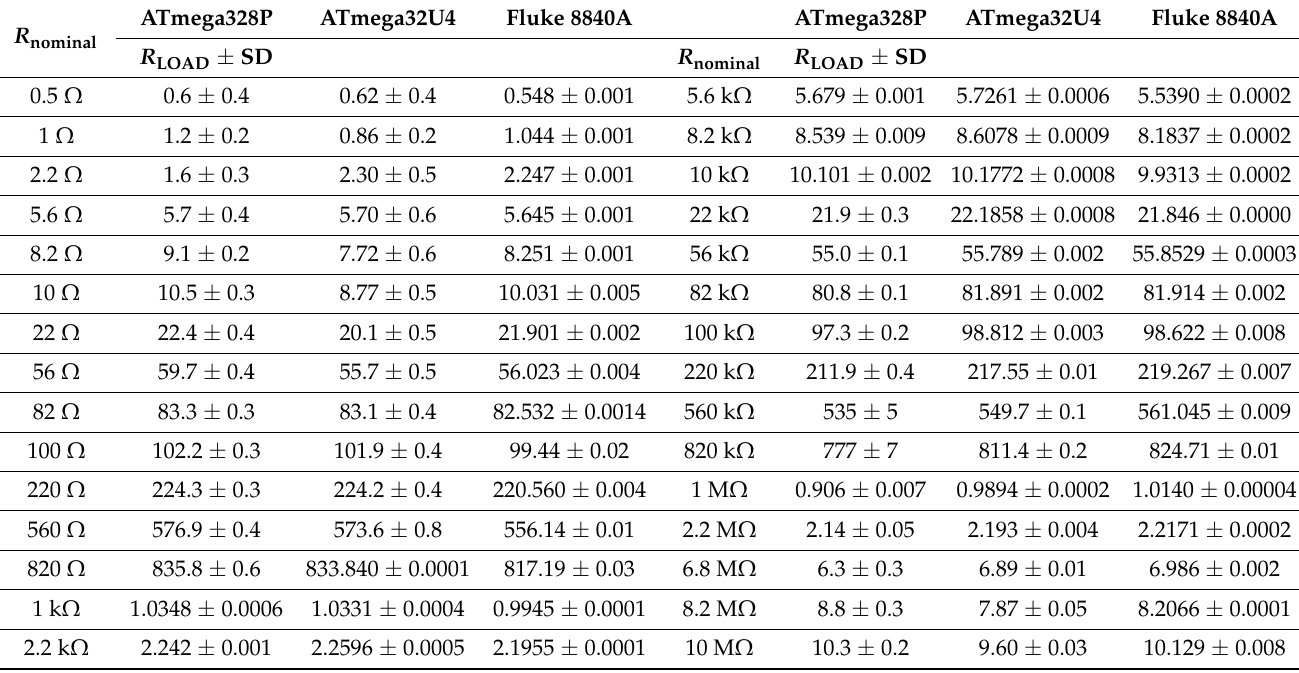
Table 3. Comparison of the ATmega328P, ATmega32U4 and Fluke 8840A measured load resistance ( R LOAD ) values ± standard deviation